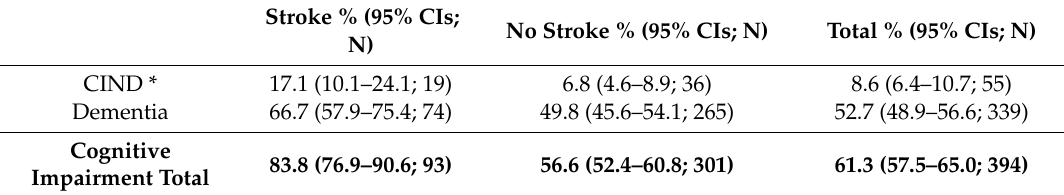
Table 2. Prevalence of stroke and cognitive impairment on admission to nursing homes in